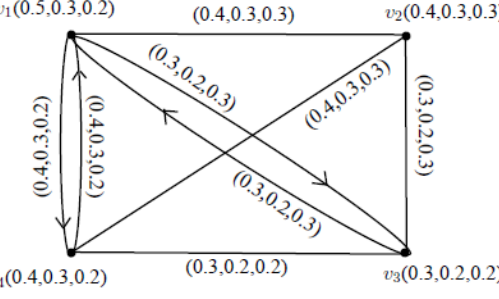
Figure 4: Complete Mixed Picture Fuzzy